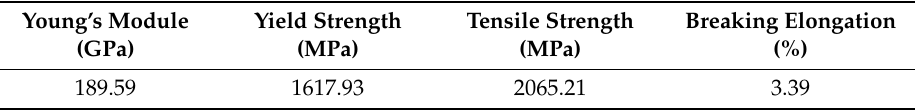
Table 6. The tested mechanical properties of a standard component.